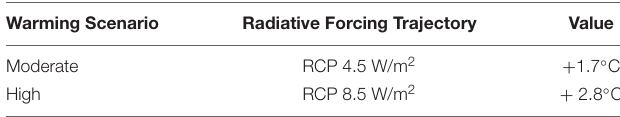
( Supplementary Table S2 ). The general formulations for each model type